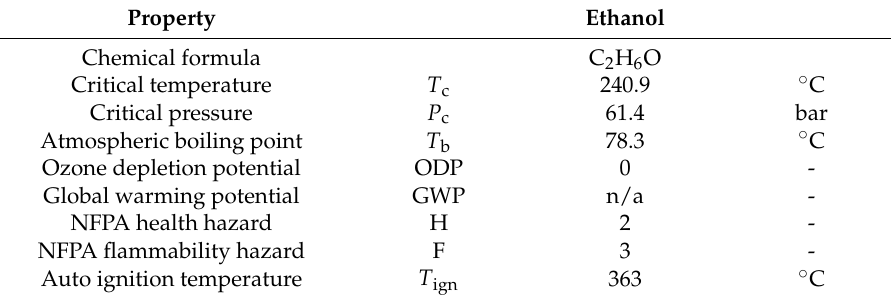
Table 4. Properties of